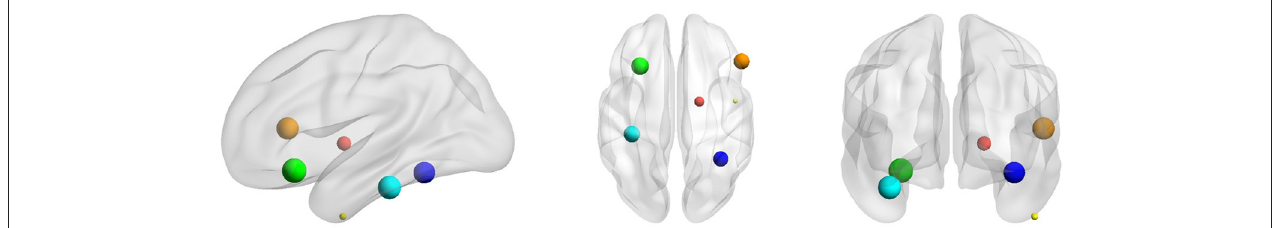
FIGURE 6 | Selected key ROIs for ASD classification, including Right Pallidum (red), Right Inferior Frontal Gyrus (triangle part) (orange), Right Inferior Temporal Gyrus (anterior division) (yellow), Left Frontal Orbital Cortex (green), Left Temporal Fusiform Cortex (posterior division) (cyan), and Right Temporal Occipital Fusiform Cortex (blue).